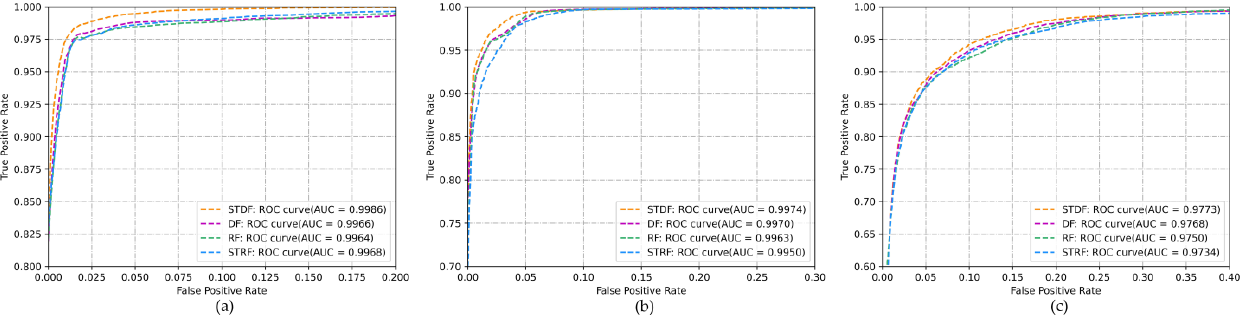
Figure 7. ROC curves and AUC values for different algorithms with respect to the dataset for the three regions: ( a ) Bishkek; ( b ) Tashkent; ( c ) Nursultan.